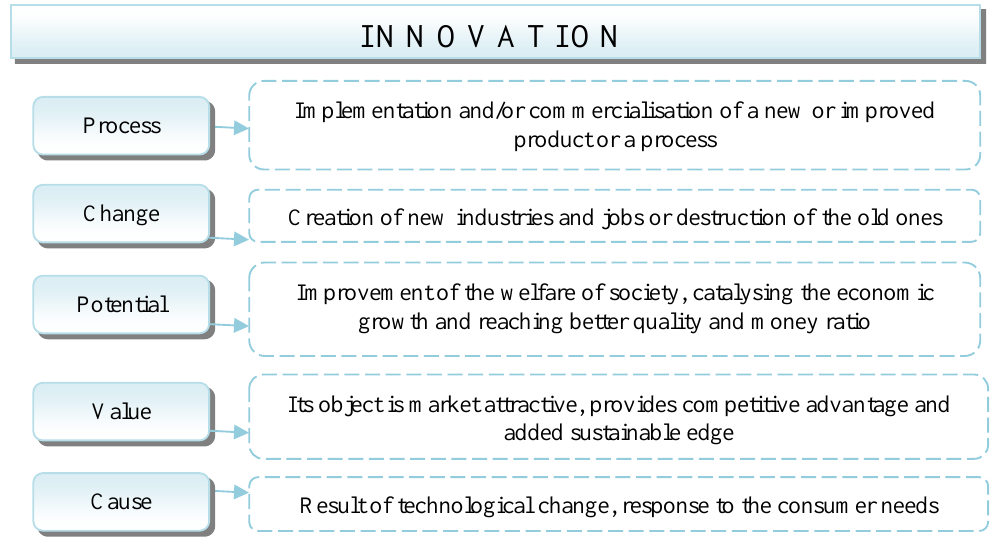
Fig. 1. Innovation concept map (created by the